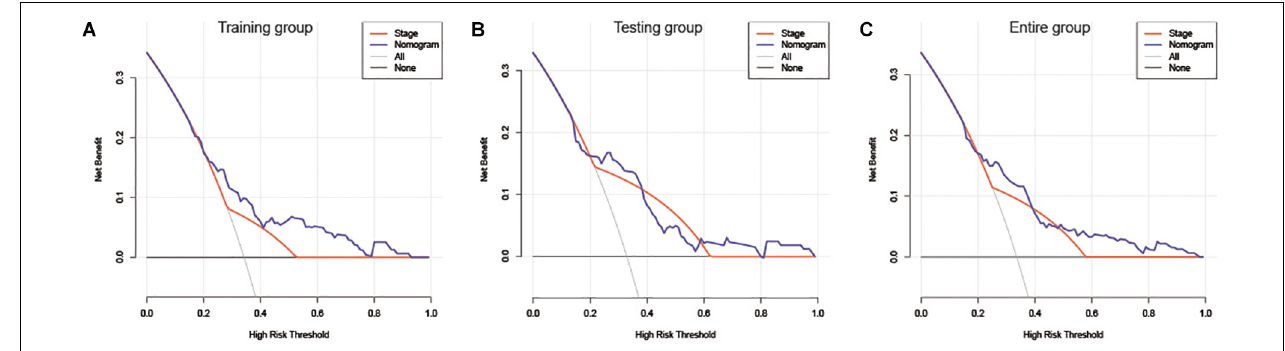
FIGURE 9 | DCA of the nomogram and AJCC stage for OS in the training group (A) , testing group (B) , and the entire group (C) . DCA, decision curve analysis; AJCC stage, American Joint Committee on cancer; OS, overall survival.